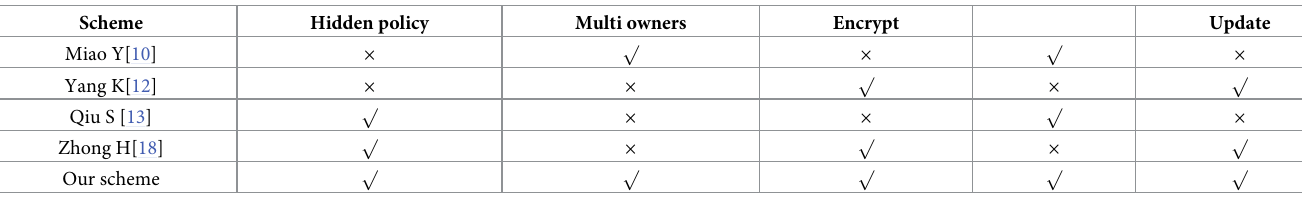
Table 2. Functional